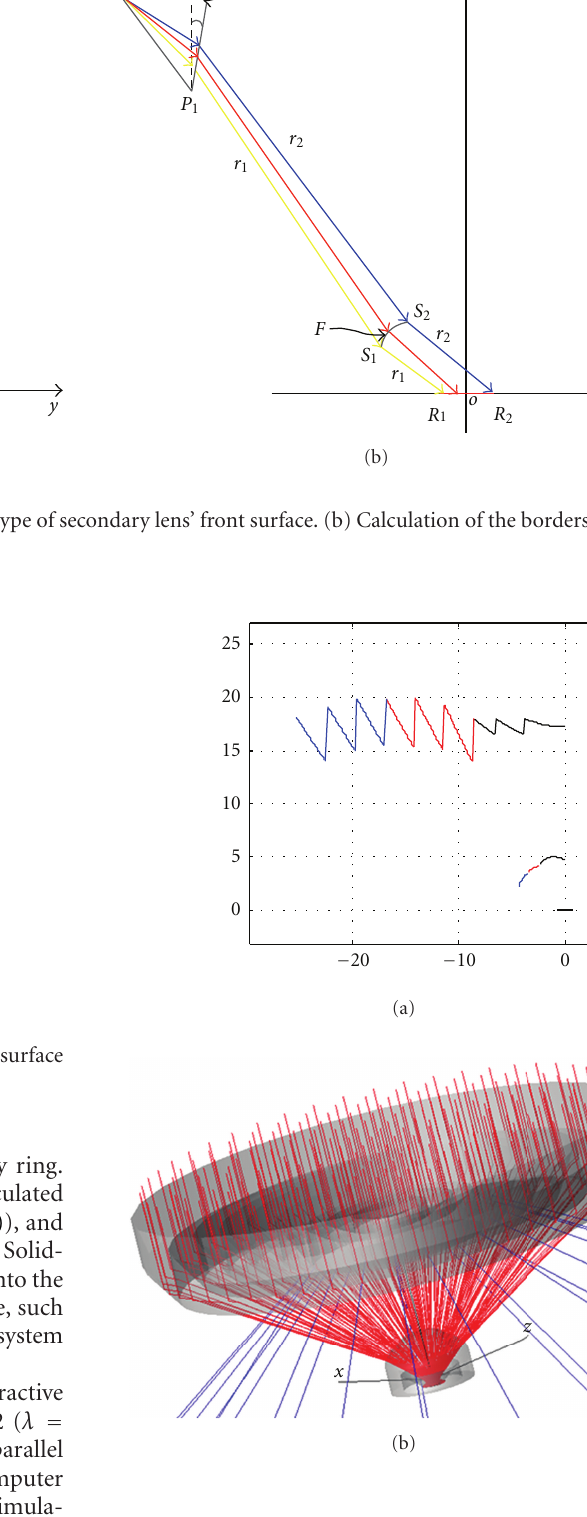
Figure 7: Profile and 3D cutaway view of a compound Fresnel-R lens for CPV